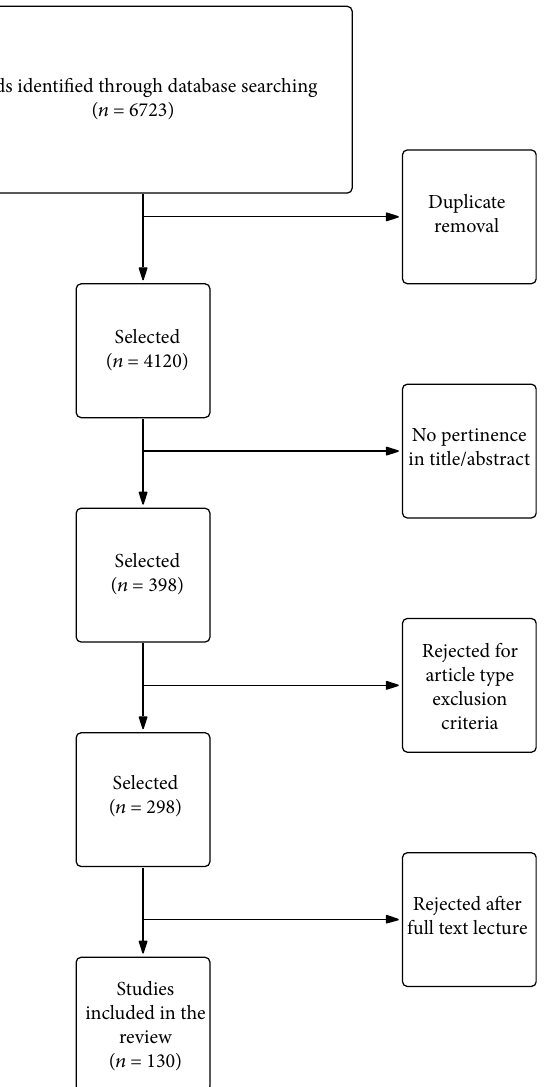
Figure 1: Systematic review